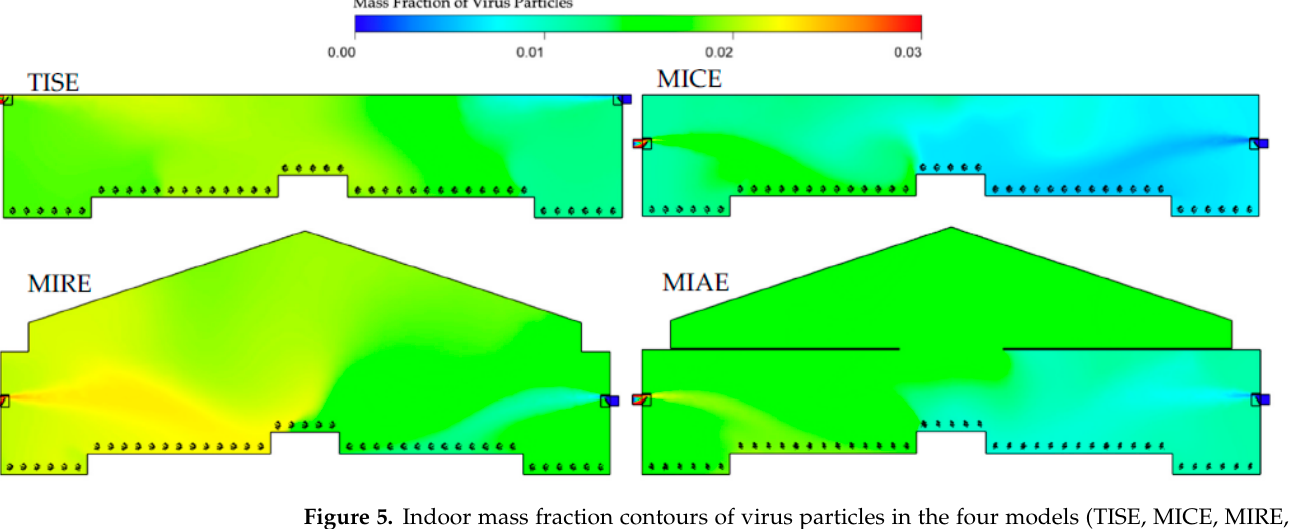
Figure 5. Indoor mass fraction contours of virus particles in the four models (TISE, MICE, MIRE, and MIAE) at the cross-sectional reference plane of CP-I. Individual modeled hens are shown at floor level.